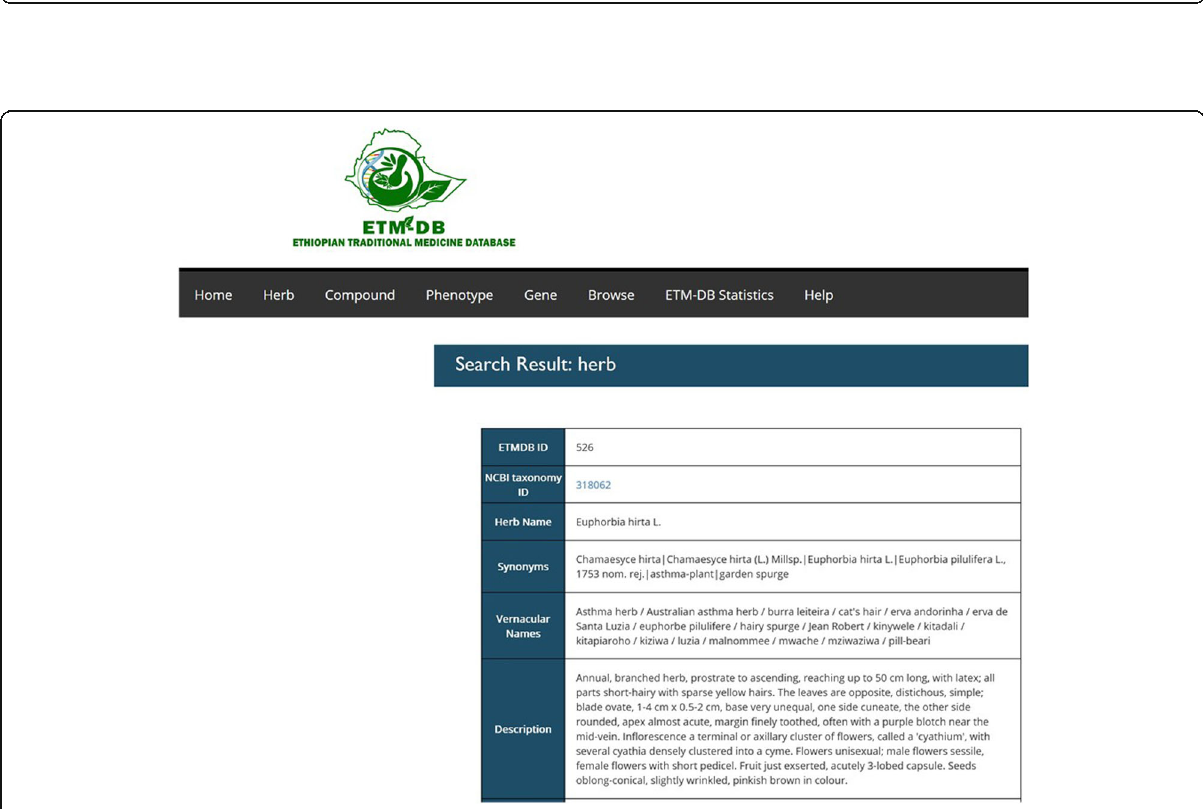
Fig. 2 ETM-DB structure. The five entity tables are herb, prescription, compound, phenotype, and target gene/protein; and the seven relationships are herb- phenotype, prescription-herb, prescription-phenotype, herb-compound, compound-phenotype, compound-gene/protein, and phenotype-gene/protein